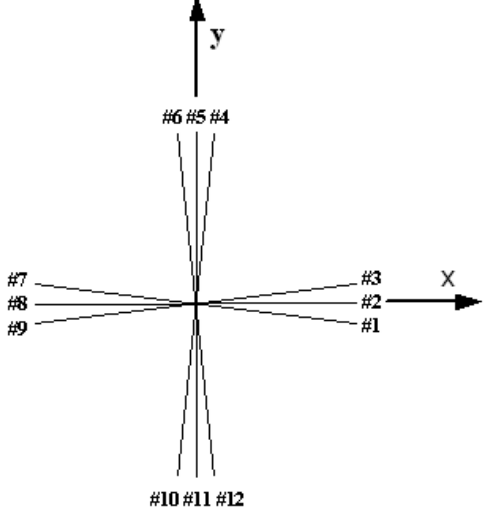
Figure 10. America Petroleum Institute (API) Wind Spectrum.